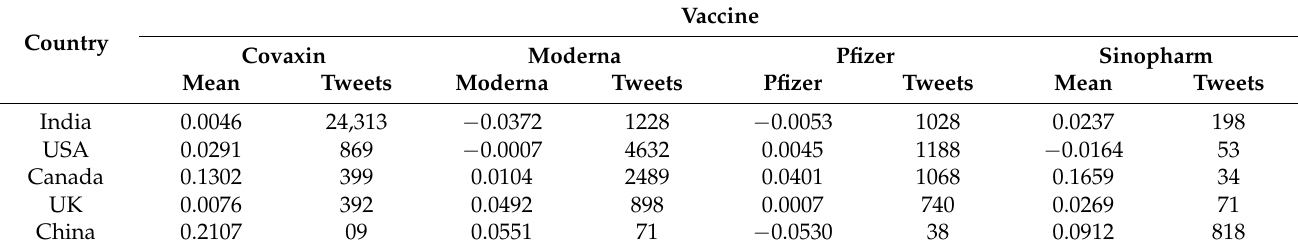
Table 4. The average of sentiments and number of tweets in the top five most posted